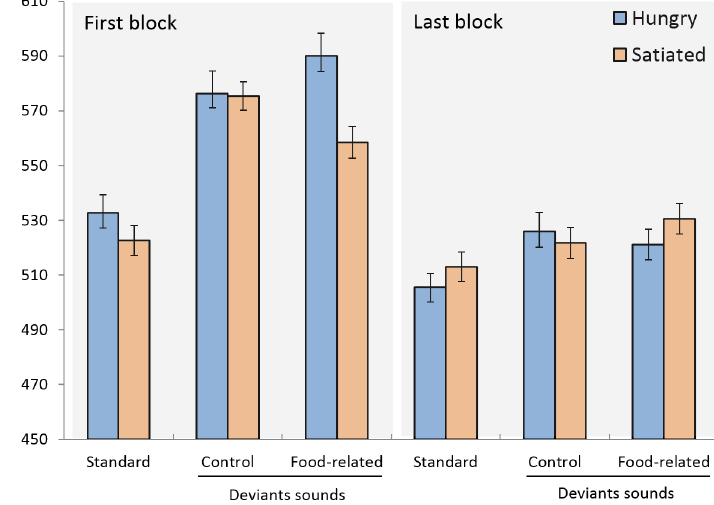
Fig 2. Mean response time for correct responses as a function of the sound conditions, block and group. Error bars represent one standard error of the mean.